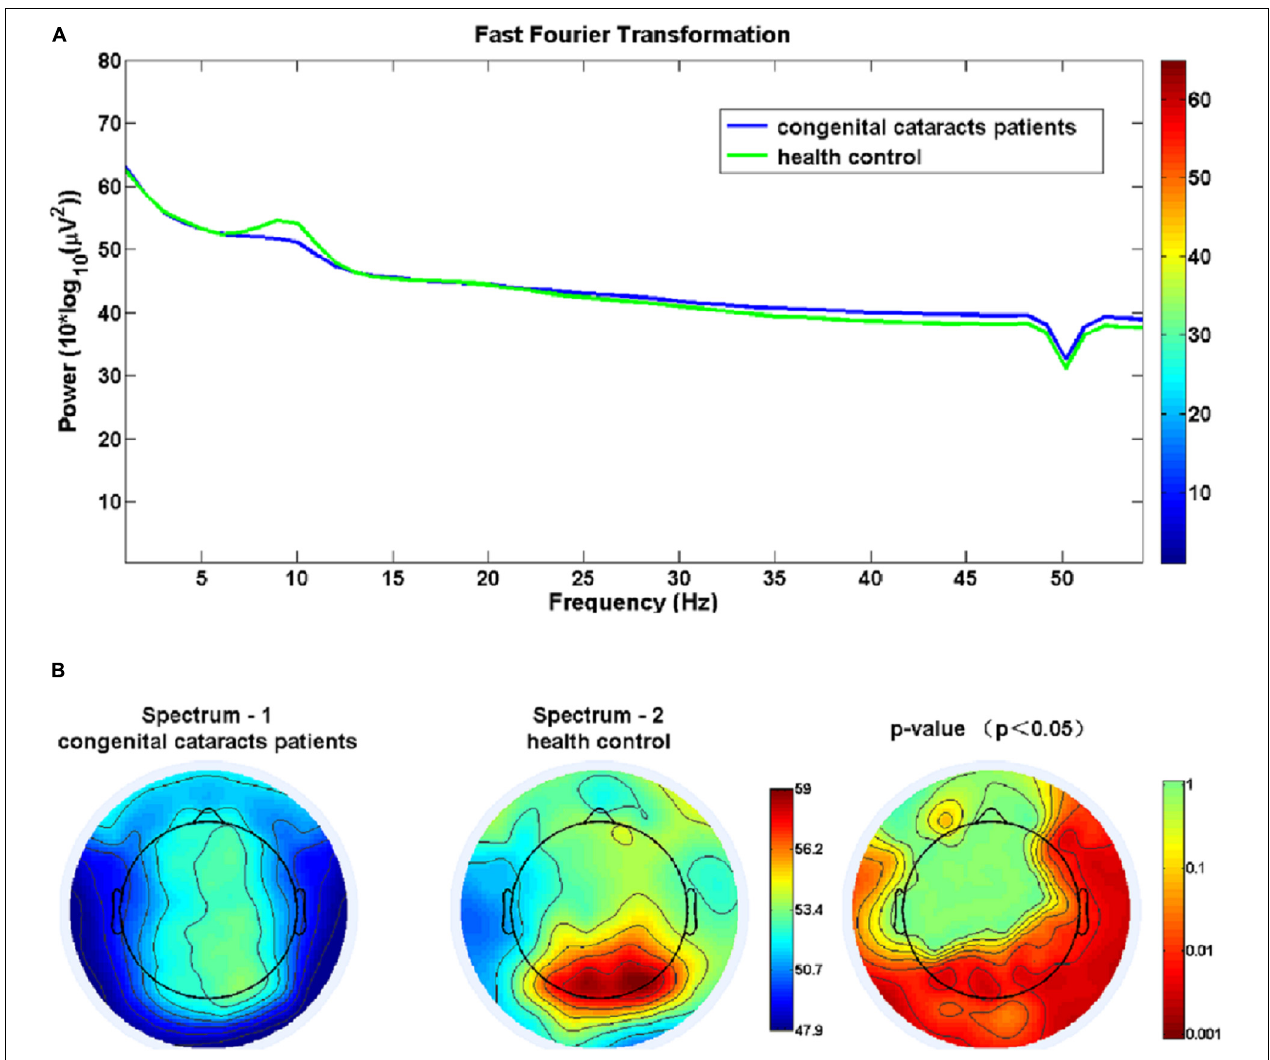
FIGURE 1 | (A) Congenital cataract patients had a significant reduction in alpha frequency compared with healthy controls using fast Fourier transformation. (B) Significant group differences in the alpha frequency in the occipital and right temporal cortices ( p <